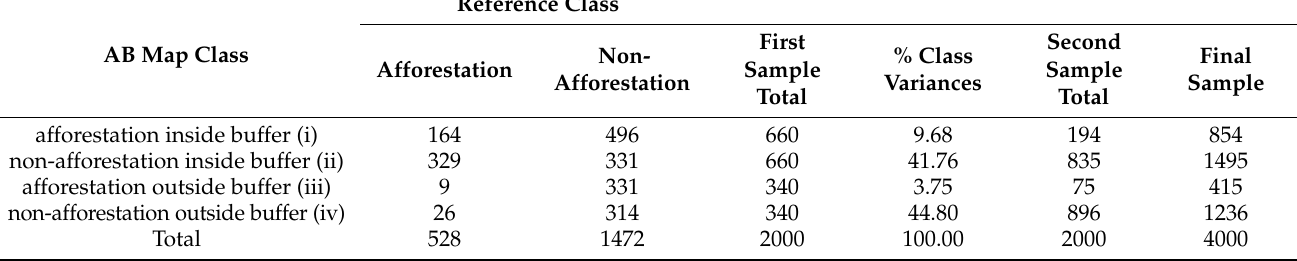
Table A1. Selection of first and second estimation sample dataset. The first estimation sample dataset composed of 2000 sample points. Per-class variance and resulting second sample selection. Through this procedure, the 2000 random points were selected in direct proportion to the variance of the first sample of points. At the end, the estimation sample dataset of 4000 points used for the next steps was